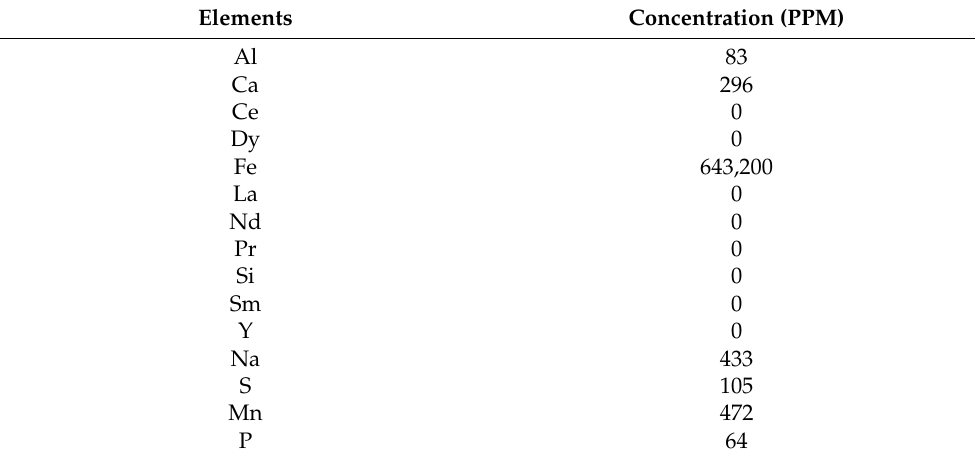
Table 1. Impurities in the FeO x (P2) sample analyzed with ICP.